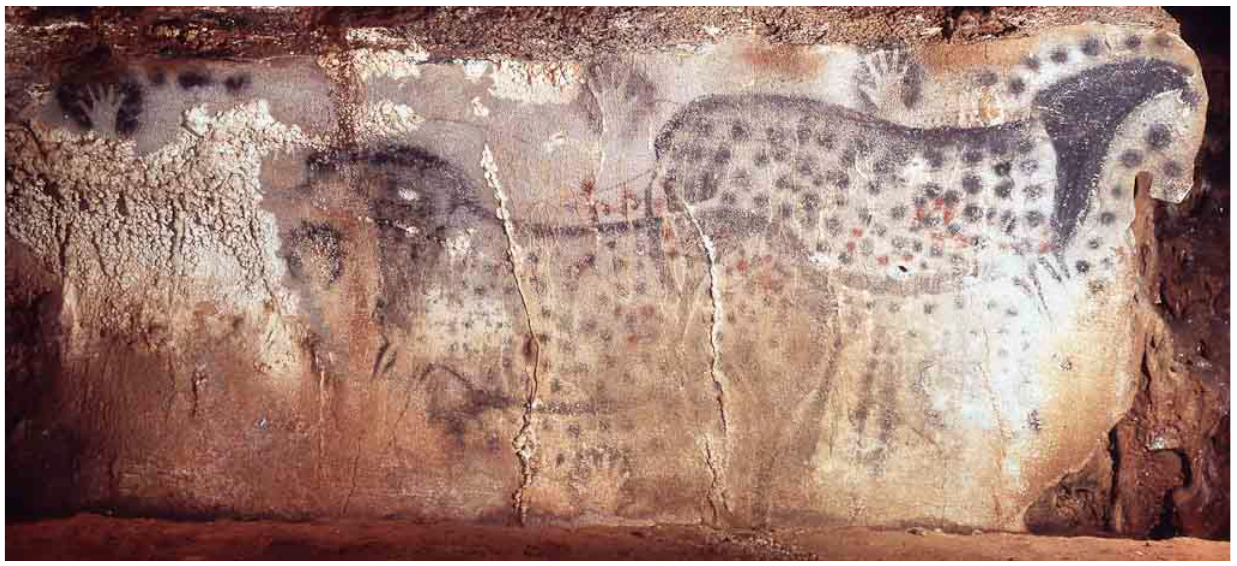
Figure 8. Spotted horses panel with spots restored By permission Centre de Prehistoire du Pech